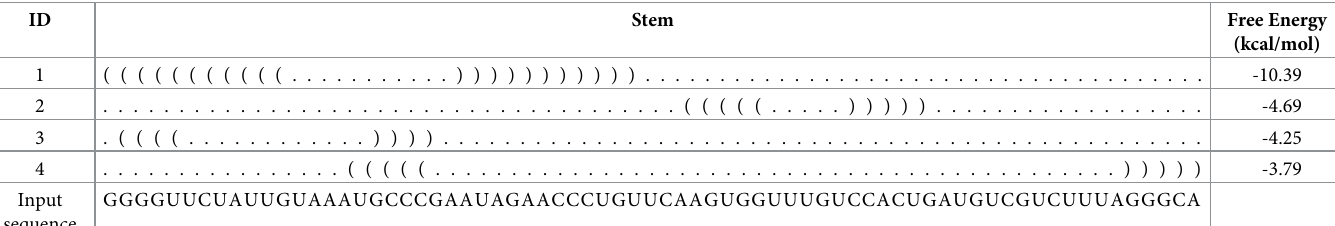
Table 6. Top four energetically favourable stems predicted for MERS-CoV − 1 PRF stimulating pseudoknot reference sequence. These stems were used as structural constraint to Iterative HFold program to predict the secondary structure of the − 1 PRF stimulating pseudoknot. First column provides stem IDs, the second column pres- ents the predicted stems in dot-bracket format and the third column lists free energy of the given stem in kcal/mol. Input sequence provided in bottom row. See Table D in S1 File for complete table.